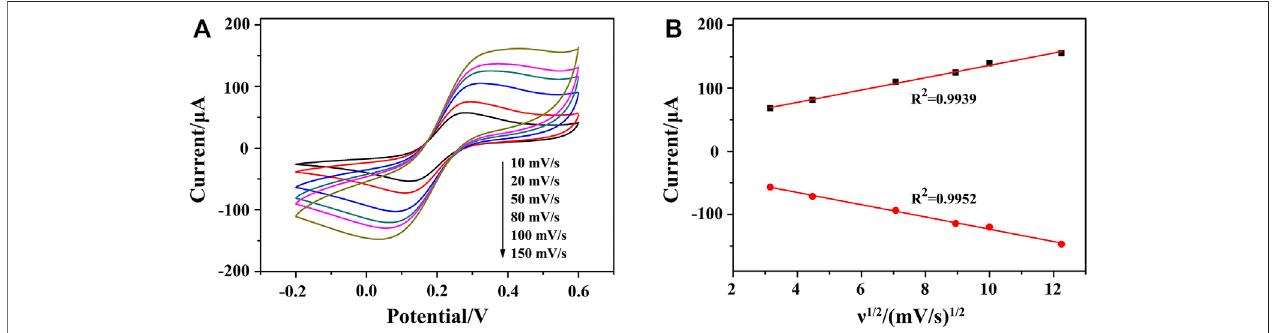
FIGURE5 |(A) CVs ofHP1/AuNPs/ZIF-8/ITO at the scanrate of10, 20,50, 80, 100, and 150 mV s − 1 (frominternal toexternal) inPBS solution containing 5.0 mM [Fe(CN) 6 ] 3 − / 4 − , respectively. (B) The corresponding plot of peak current vs . ν 1/2 .